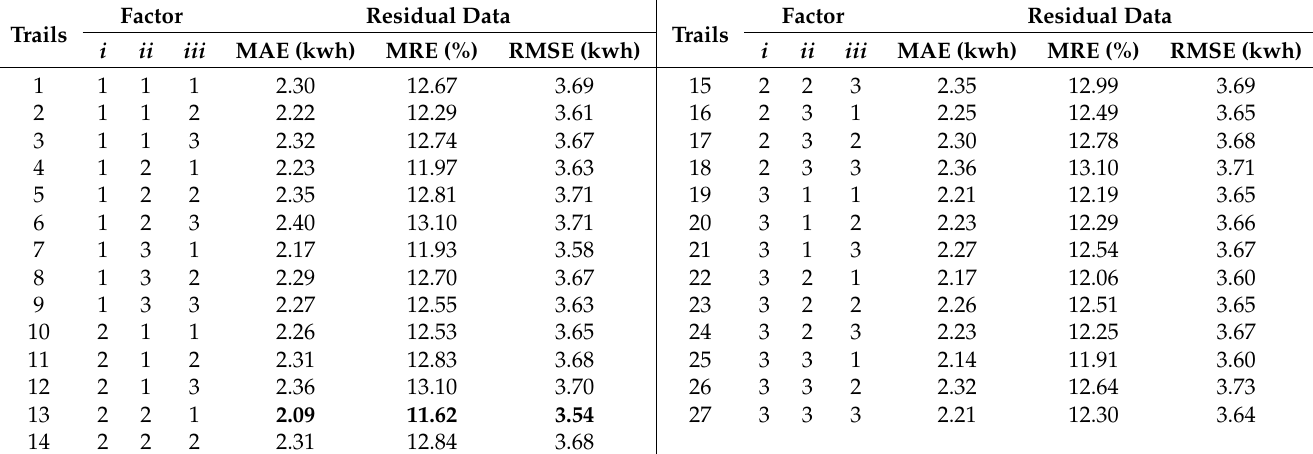
Table 4. Experimental results of the MDBN in 27 trails under the consideration of three design factors and their corresponding